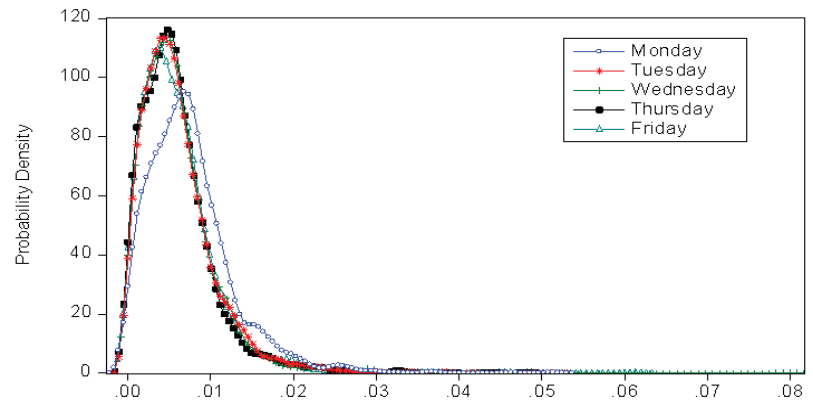
Fig. 10. Probability distributions of gold volatility from Monday to Friday in